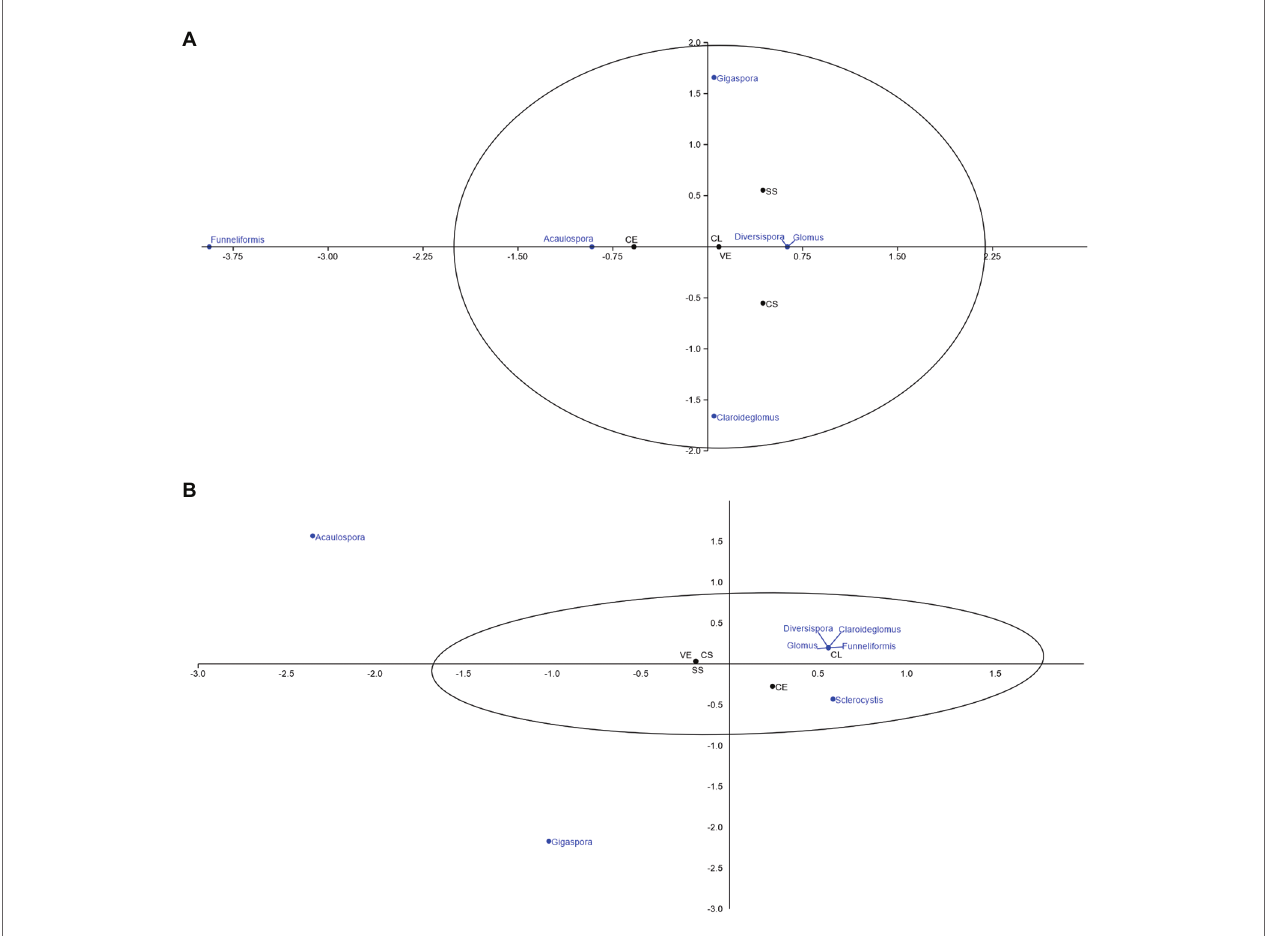
FIGURE 5 | Canonical correspondence of mycorrhizal fungi associated with different Cerrado phytophysiognomies in the dry season. (A) June and (B) September. CL, Campo Limpo; CS, Campo Sujo; SS, Strictu Sensu; CE, Cerradão; and VE,